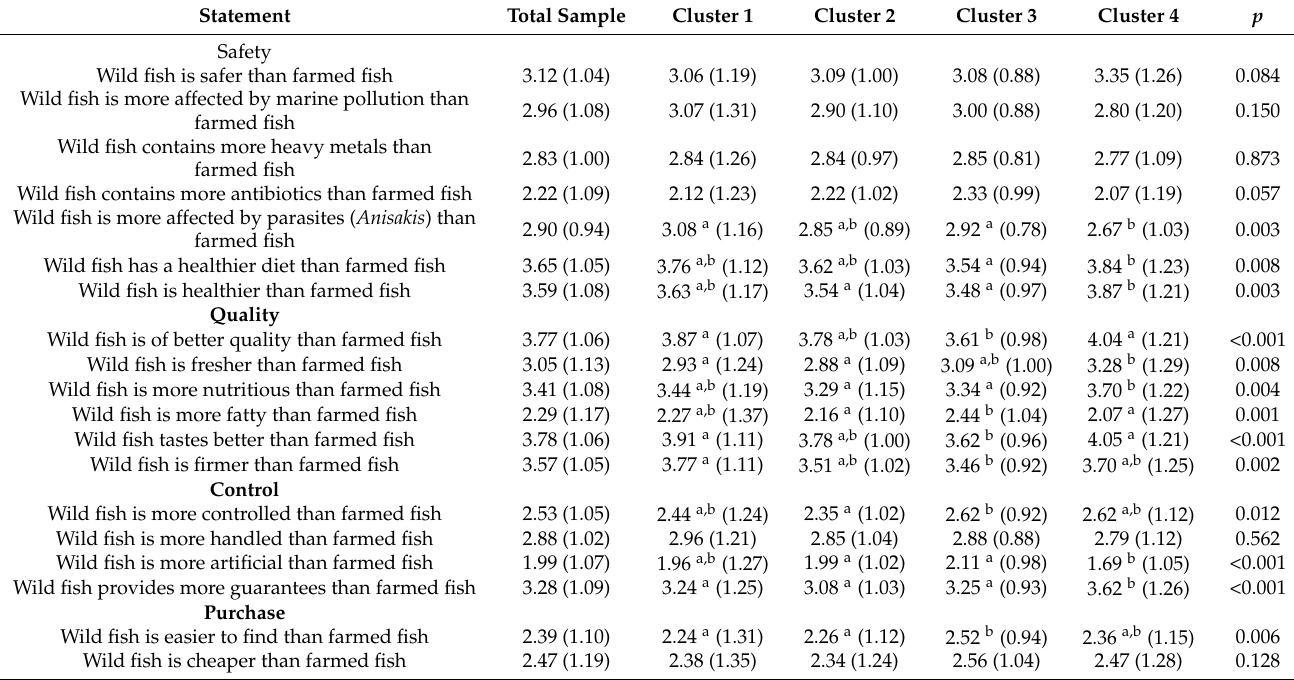
Table 3. Beliefs about wild and farmed fish of Croatian fishery consumers (n =